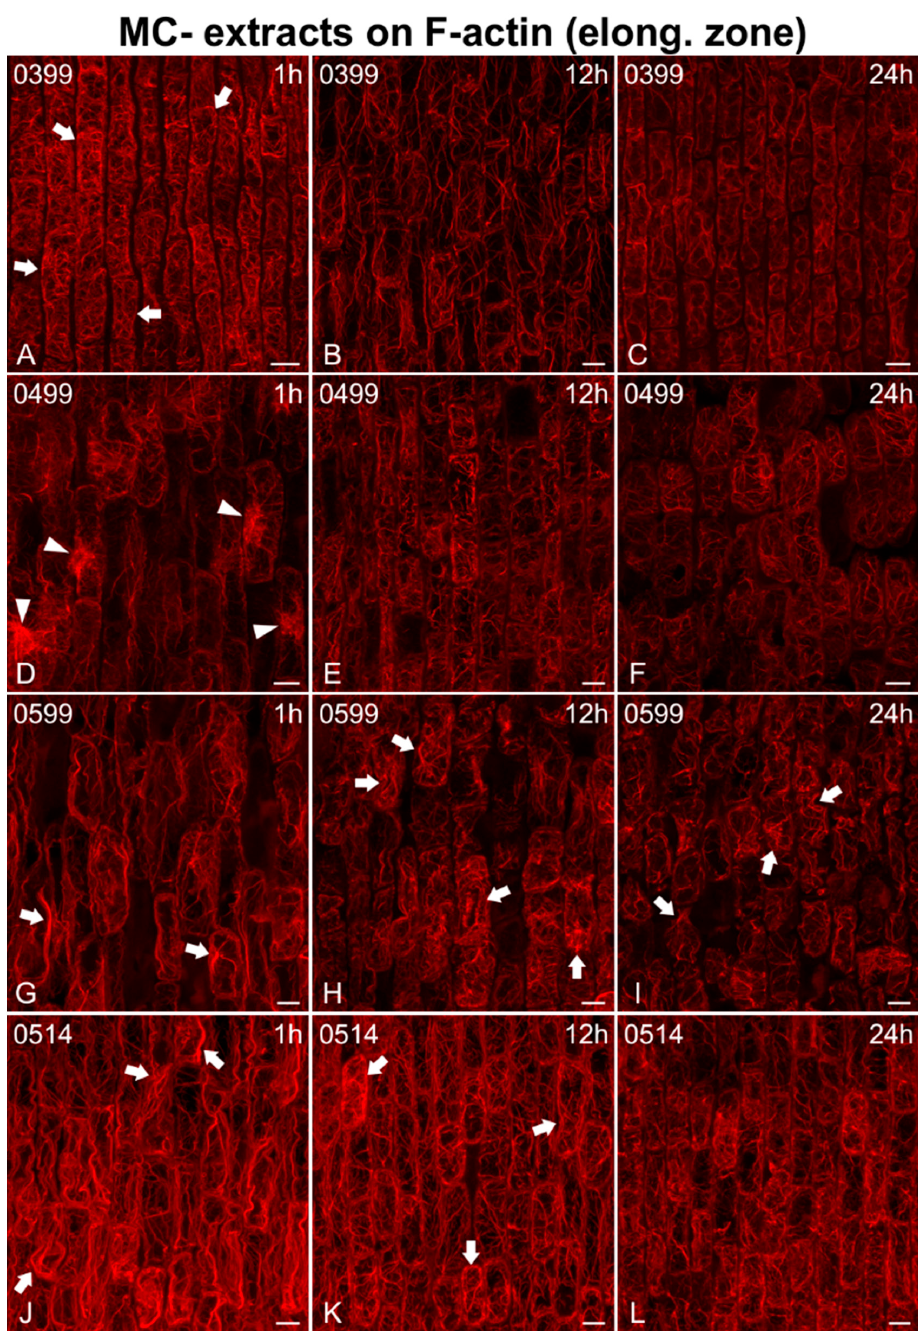
Figure 8. Maximum intensity projections of serial CLSM sections of Oryza sativa epidermal cells in the root elongation zone, stained for F-actin, after treatment with MC − extracts from various non-MC-producing strains: Calothrix epiphytica TAU-MAC 0399 ( A – C ), Synechococcus sp. TAU-MAC 0499 ( D – F ), Chlorogloeopsis fritschii TAU-MAC 0599 ( G – I ), and Planktothrix agardhii TAU-MAC 1614 ( J – L ). Root tips in all images point towards the bottom of the page. After 1 h of treatment, F-actin was disoriented (arrows in A ) or exhibited actin aggregates (arrowheads in D ) and minor bundling e ff ects (arrows in G , J ). Diminishing of the F-actin network ( B , E ) and bundling of actin cables (arrows in H , K ) were visible after 12 h. F-actin was further degraded after 24 h ( C , F , I , L ), with some bundling e ff ects observed (arrows in I ). Scale bars: 10 µ